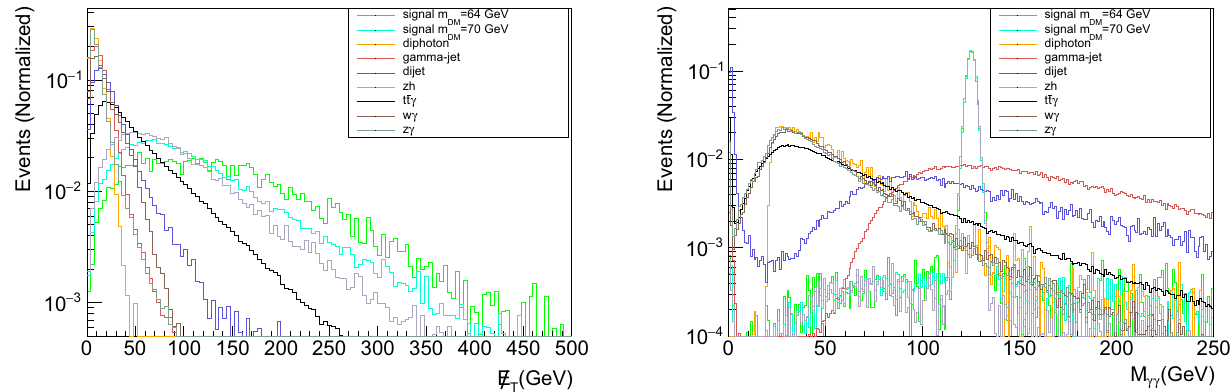
Fig. 9 Normalized distributions of / E T (left) and invariant mass of leading and sub-leading (right) photons